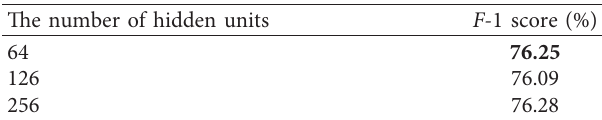
Figure 8: The F -1 score of different LSTM layer settings in STCN. Table 4: F -1 scores of STCN models with different LSTM hidden units.